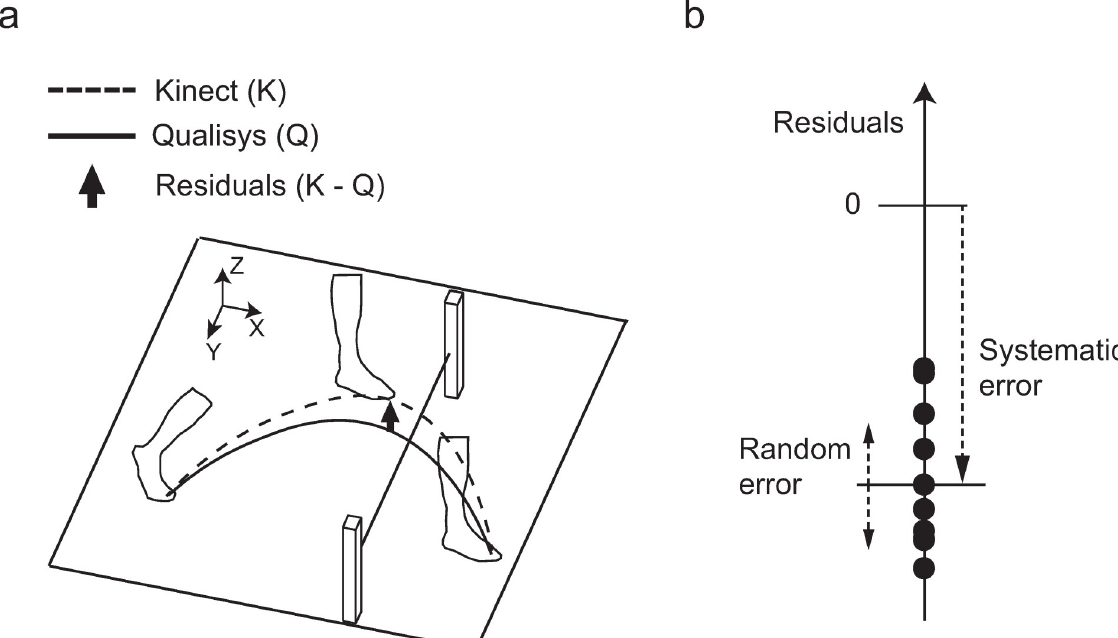
Fig 4. Calculation of the systematic and random error. Residuals were calculated by subtracting Qualisys from Kinect (a). The systematic error and random error were defined as the mean and standard deviation, respectively, of the residuals (b).